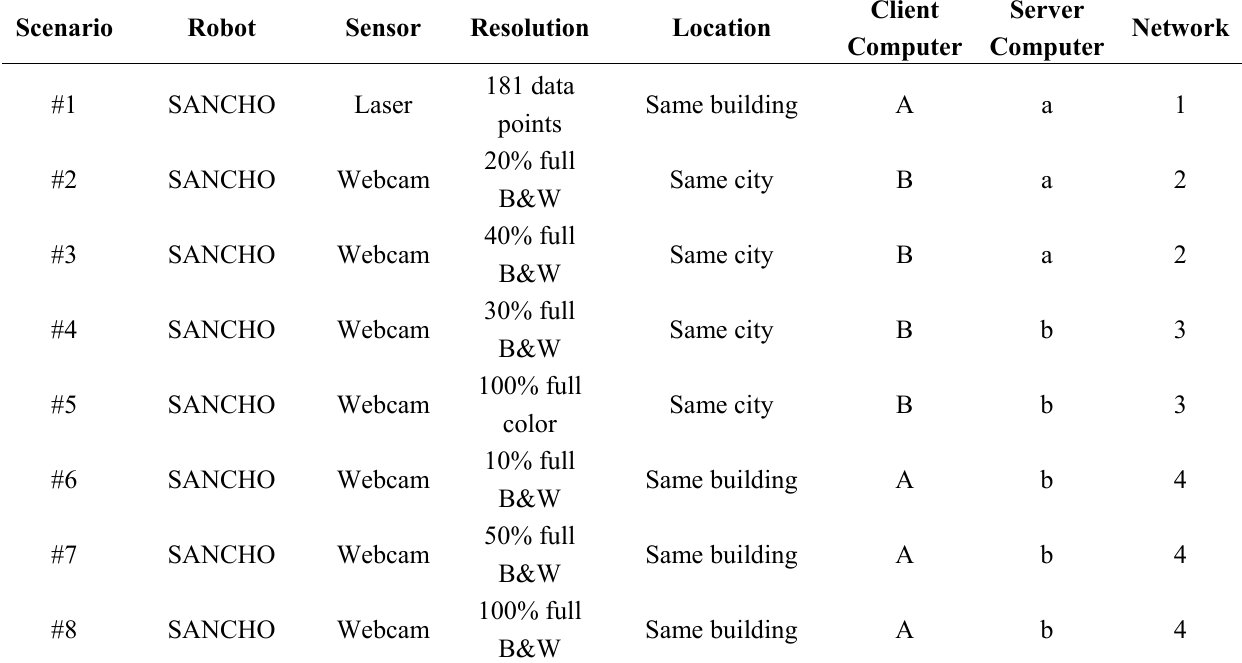
Table 1. Summary of the experimental scenarios that have been set up for modeling the delay in sensory data transmission from our networked telerobots (more details on the elements of this table can be consulted in the main